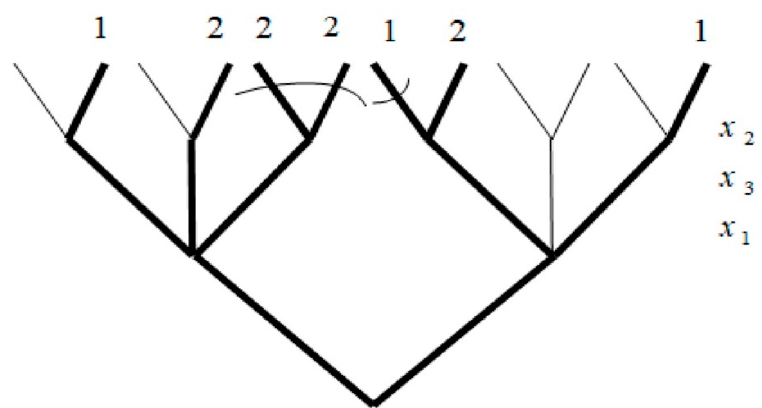
Figure 7. MZAPN logic tree of the multivalued logic function f ( x 1 , x 3 , x 2 ) from Example 3. The proposed methodology can be described by the flow chart shown in Figure 8.